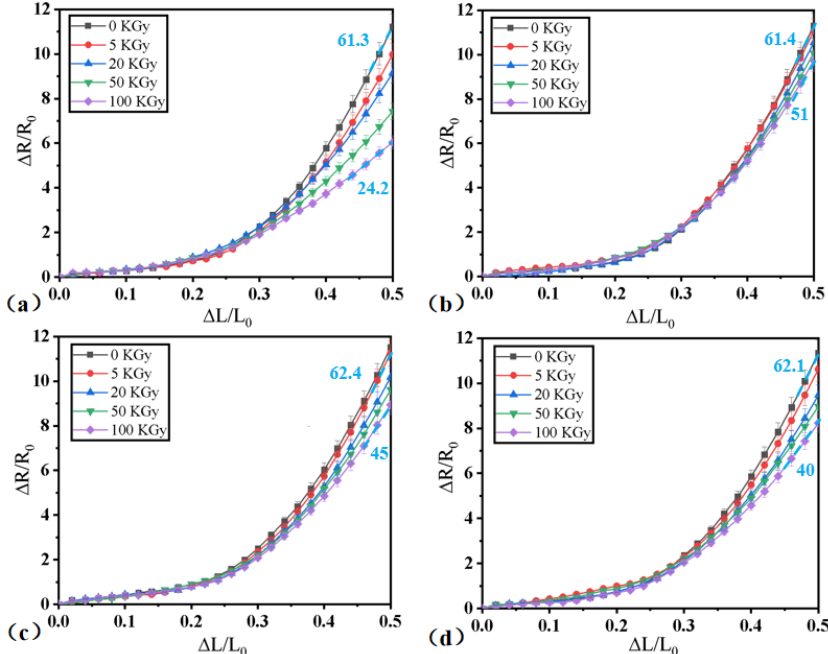
Figure 5. The force-sensitive characteristics of the structure after different doses of gamma irradiation; ( a ) the CNT sponge/PDMS and when the particle size of tungsten oxide was ( b ) 50 nm; ( c ) 100 nm; ( d ) 1 μ m.